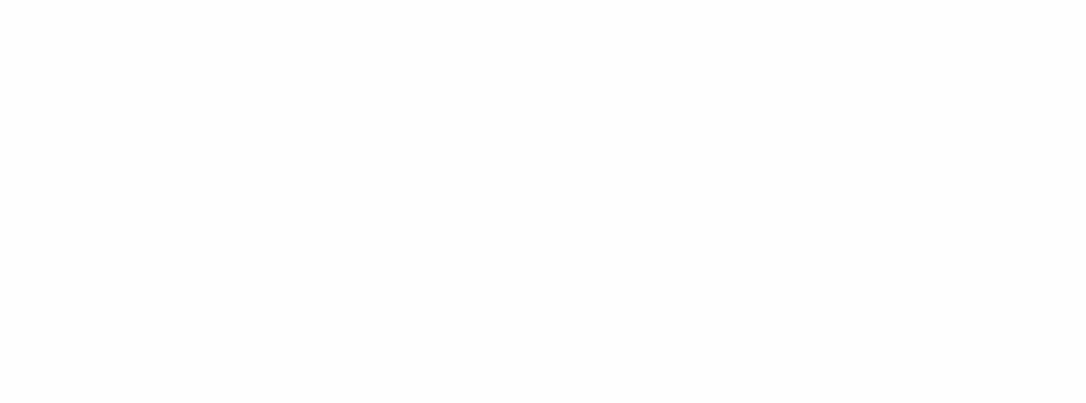
FIGURE 2 The influence of chemokines at a concentration of 50 ng/ml on the number of motile MOLT 4 and Jurkat T cells on a fibronectin coated plastic surface (coated over night at +4C with fibronectin 20